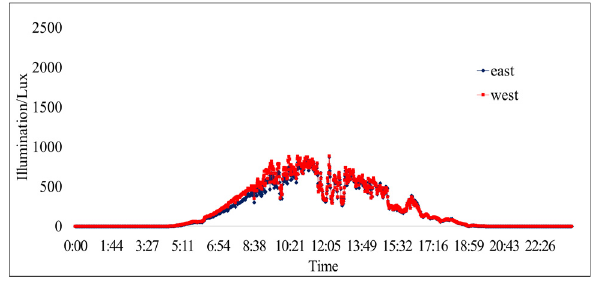
Figure 13. Illuminance monitoring data on June 21, 2016